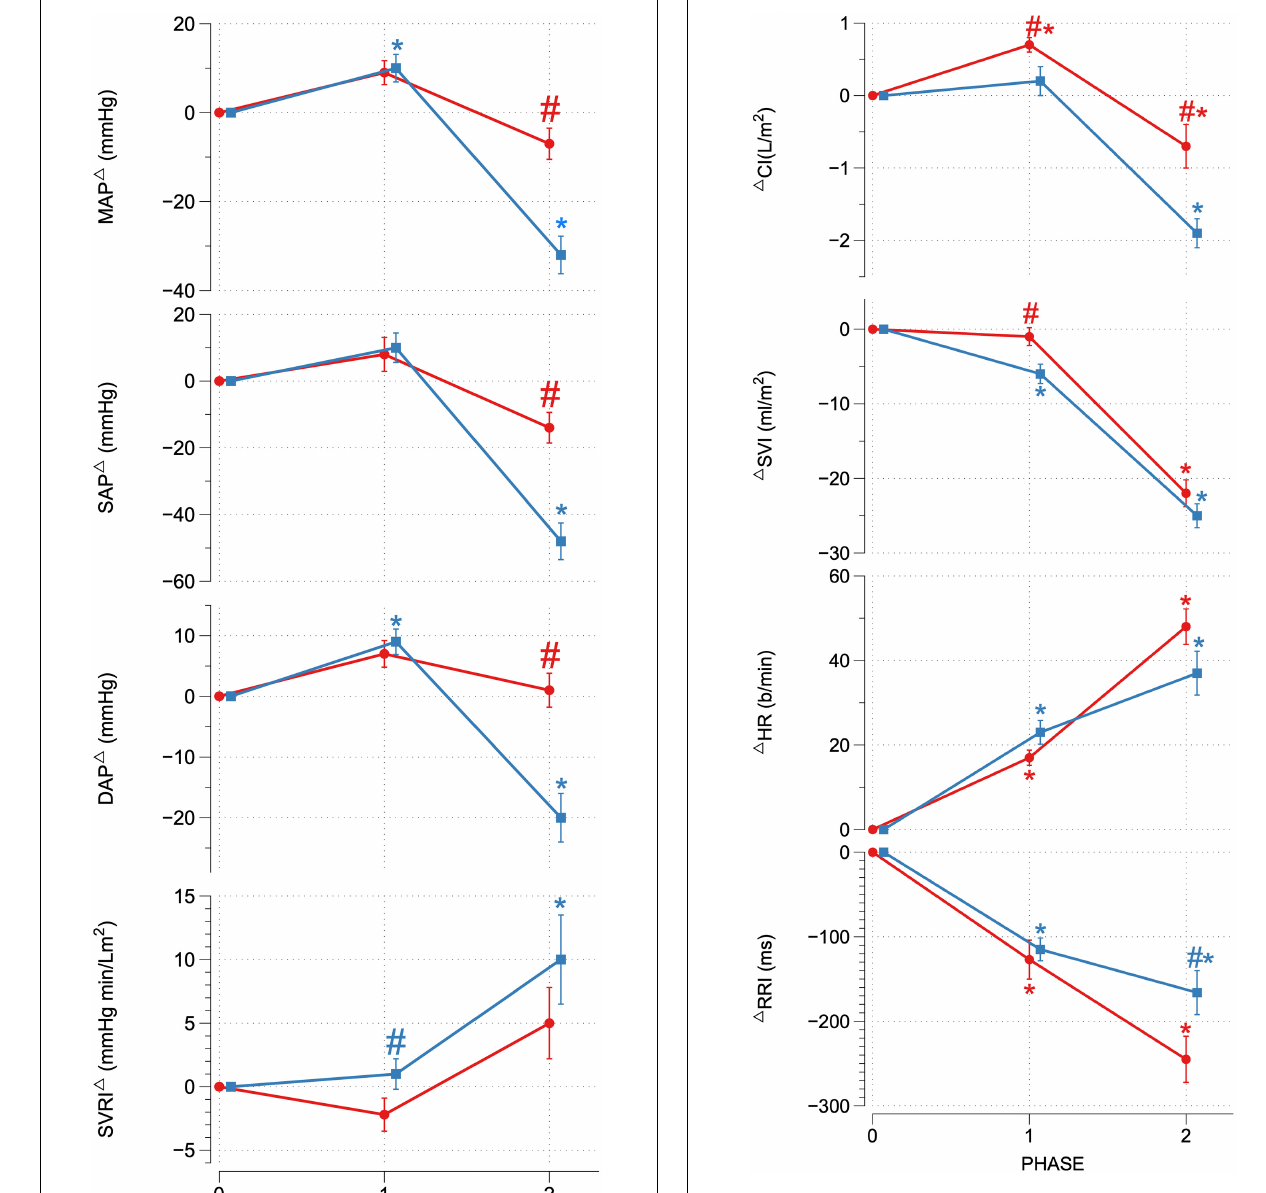
FIGURE 2 | Delta CI, SVI, HR, and RRI for OR (red) and OI (blue) during SHHOC. # Significant difference between groups. *Significant change from